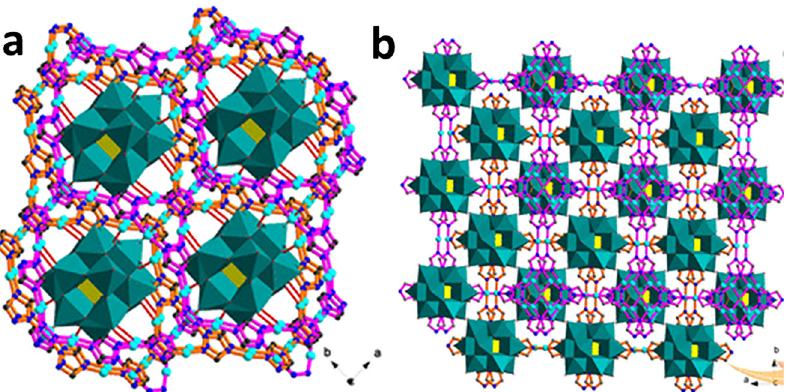
Figure 9: Structural difference of [ α -SiW 12 O 40 ]·2H 2 O encapsulated in nine- membered [CuI 12 (trz) 8 (H 2 O) 24 + (a) POMOF1 and [ α -PW 12 O 40 ] 3 − encapsulated in 2D bilayer of [CuI 12 (trz) 8 Cl] 3 + , (b) POMOF2. Adopted with permission from ref.